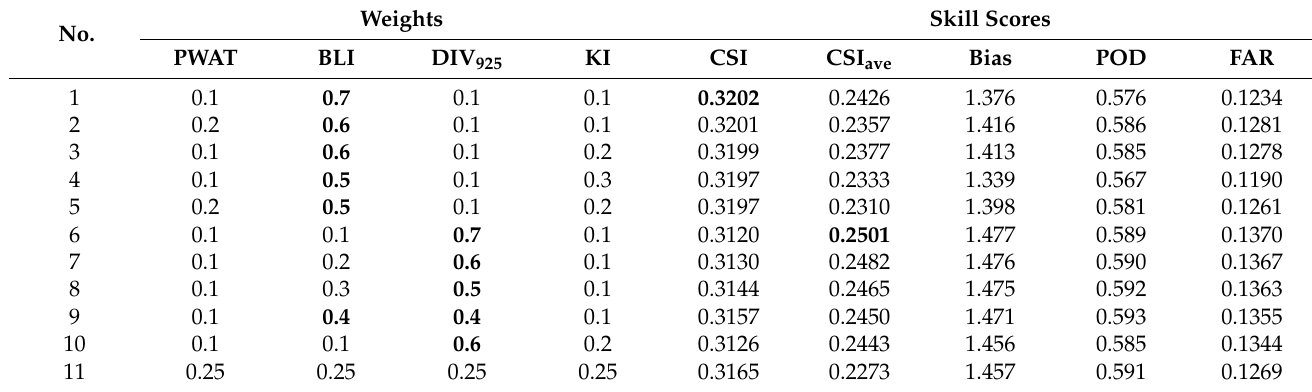
Table 4. Weights of groups with the maximum CSI and CSI ave for the 00–12 h forecast. No. 1–5 are listed with maximum CSI, while NO. 6–10 are listed with maximum CSI ave . No. 11 in the group is assigned with equal weights. The Bias, POD, and FAR that correspond to the CSI are also given. The maximum CSI and CSI ave are bolded. The maximum weight values of each group are also